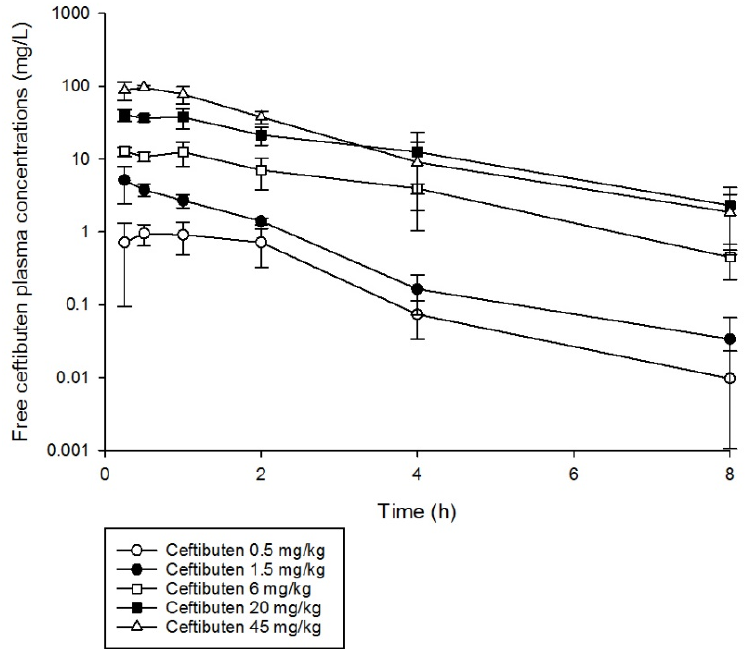
Figure 1. Ceftibuten free plasma concentration–time profiles in a neutropenic mouse thigh infection model following the administration of single subcutaneous doses (0.5–45 mg/kg).